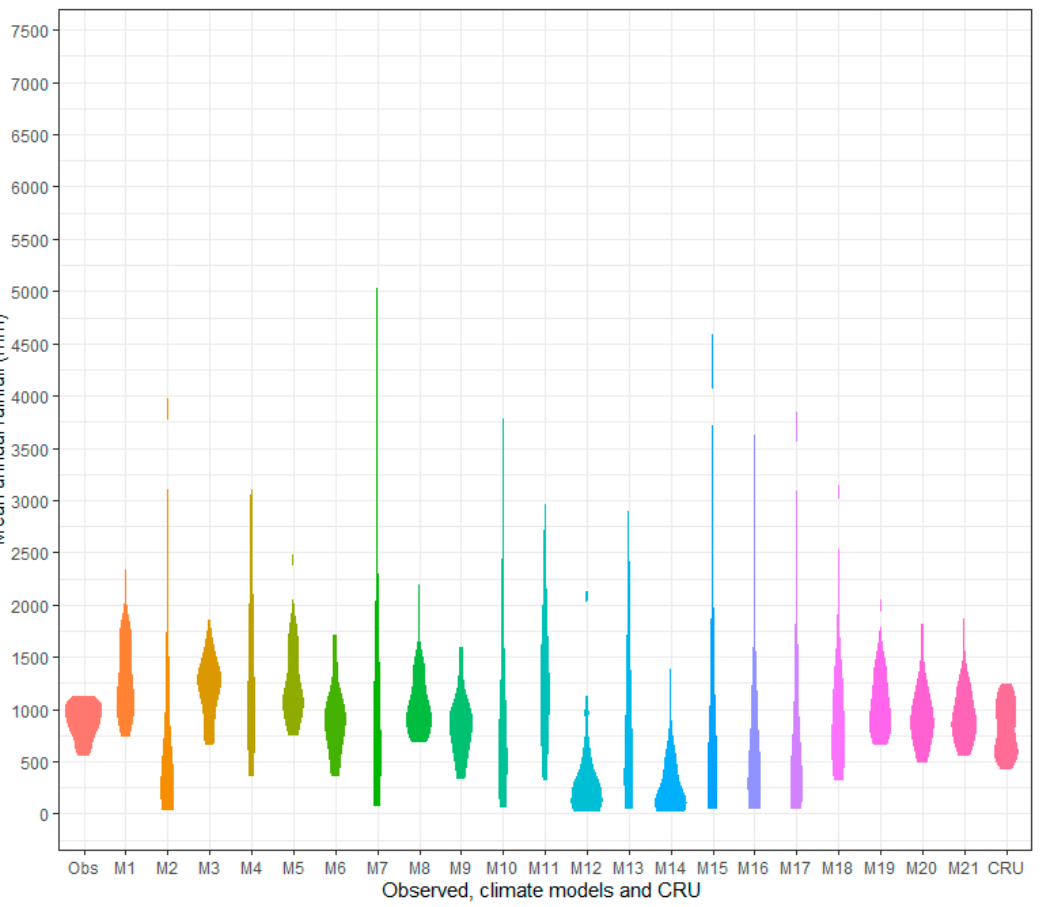
Figure 7. Density plot that shows the spatial variability of rainfall from observed data (Obs), CORDEX climate models (M1–M17), their ensembles (M18–M21), and from Climate Research Unit (CRU) reanalysis rainfall data as an alternative reference.